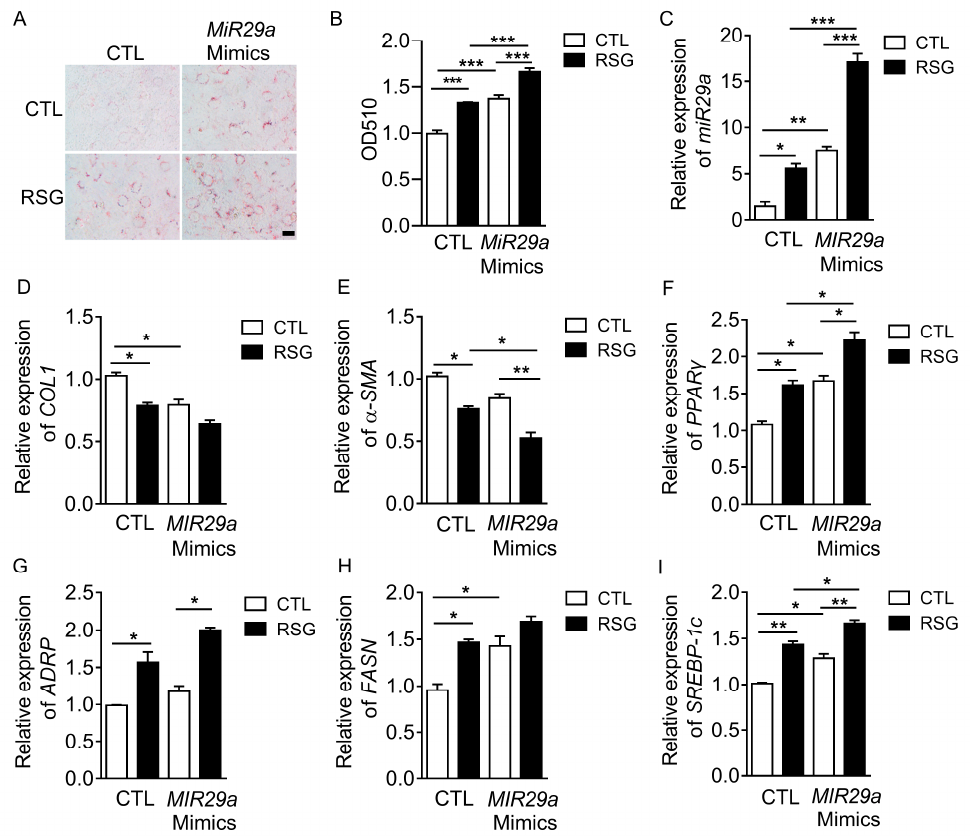
Figure 2. MIR29a mimics decreased the expression of fibrosis-related genes and increased the expression of adipogenic transcription factors. ( A , B ) MIR29a mimics (100 nM) were transiently transfected into LX-2 cells for 48 h, and the cells were treated with RSG (5 µ M) for 24 h. Conventional Oil red O staining was conducted. After removing the staining solution, the dye retained in the cells was eluted into isopropanol, and OD510 was determined. Scale bar: 10 µ m. ( C–I ) The expression of MIR29a , COL1 , α -SMA , PPAR γ , ADRP , FASN , and SREBP-1c mRNA were assessed by qRT-PCR ( n = 3 per group). Error bar represents SEM. * p < 0.05, ** p < 0.01, and *** p < 0.001.